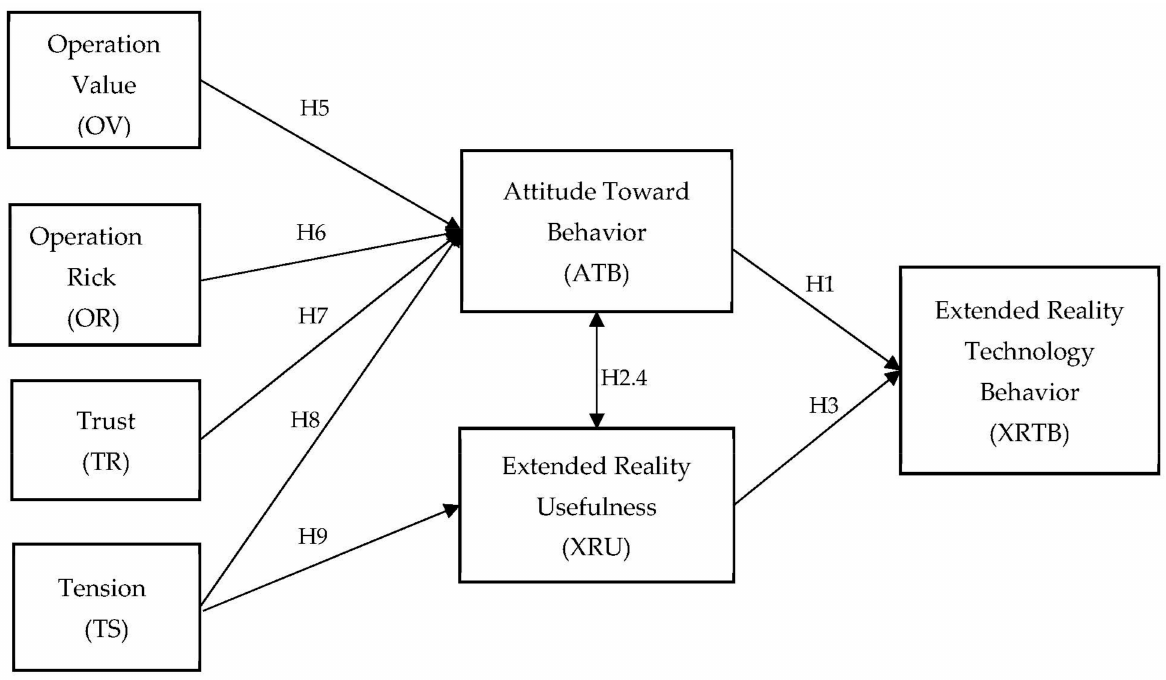
Figure 1. Hypotheses and